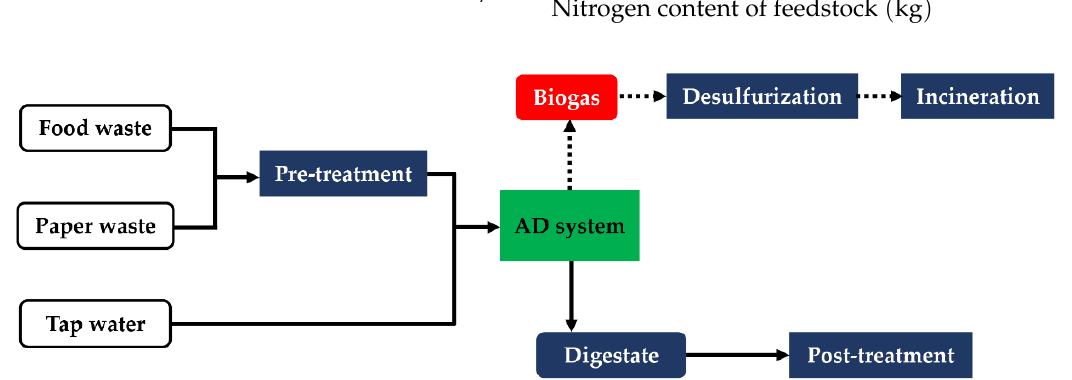
Figure 1. Anaerobic digestion process flow chart.